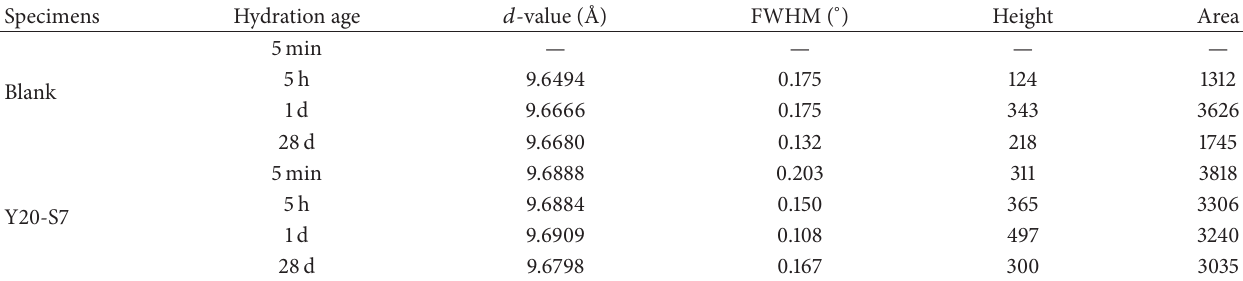
Table 4: The integrated results of XRD diffraction peak of AFt corresponding to 2 𝜃 range of 9.0–10.0 ∘ .